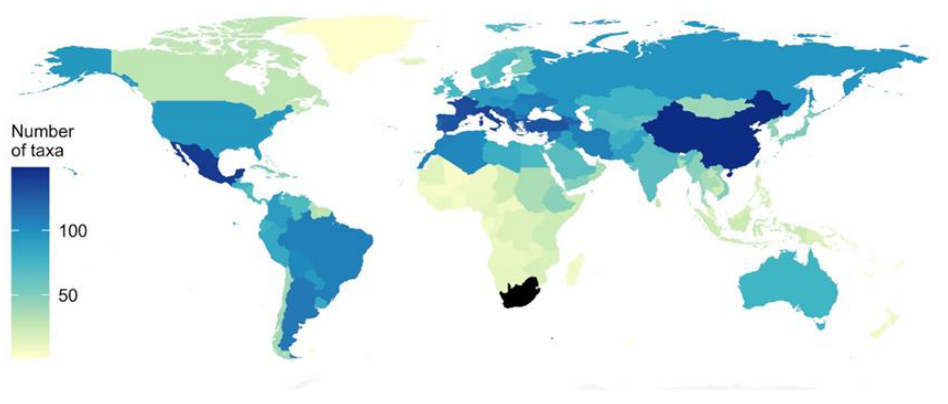
Figure 4. The native range distributions of the alien plants present within the six mountain ranges of South Africa (Table S3). The nation-wide sampling effort for SAPIA and iNaturalist across all six mountain ranges revealed that all ranges have sampling deficiencies (Figure 5). The species accumu-